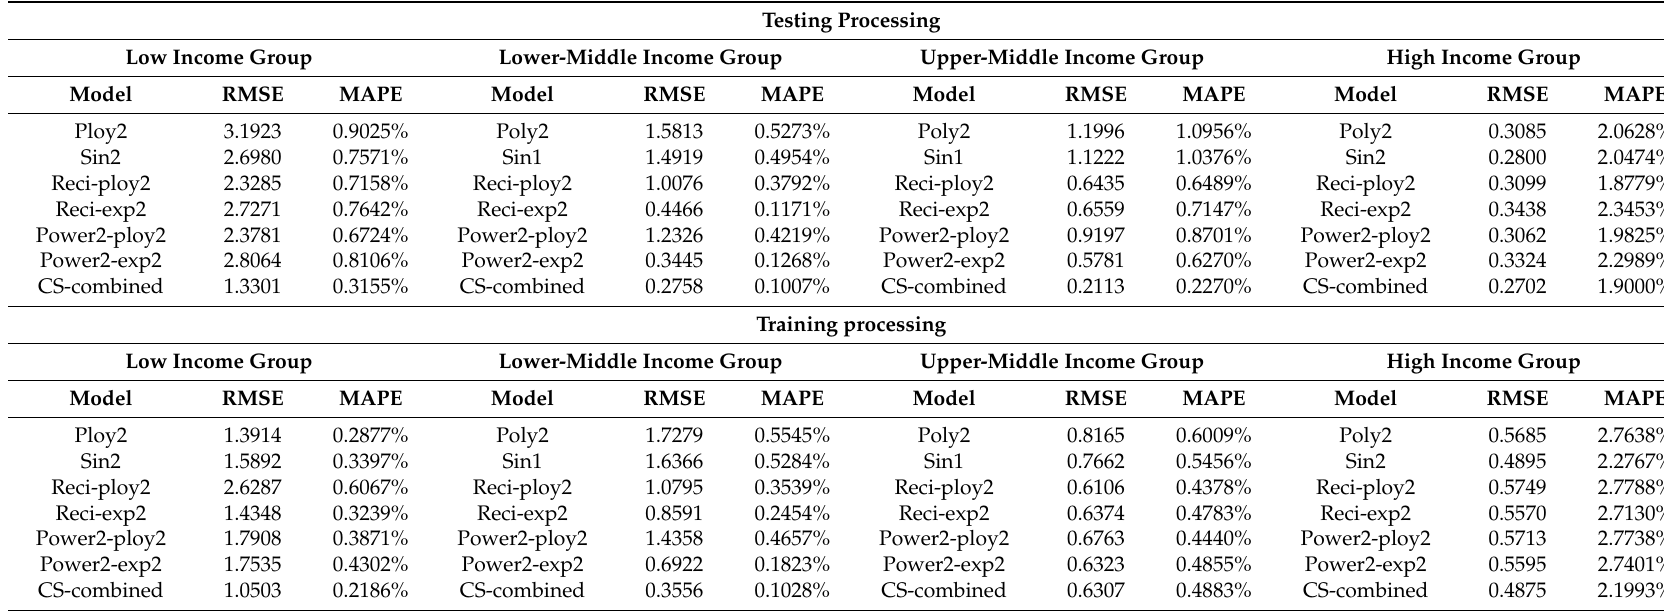
Table 5. Root mean square error (RMSE) and mean absolute percentage error (MAPE) values of forecasting